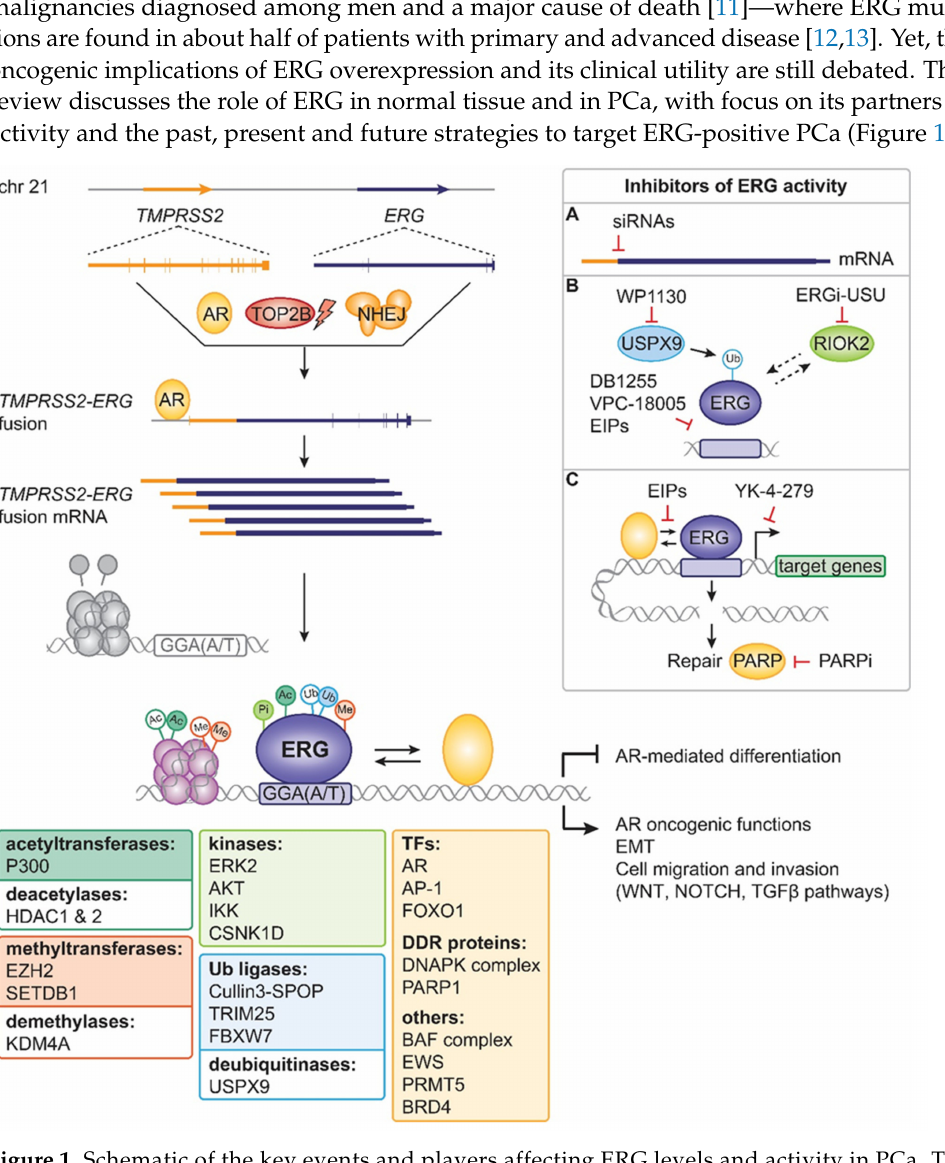
Figure 1. Schematic of the key events and players affecting ERG levels and activity in PCa.